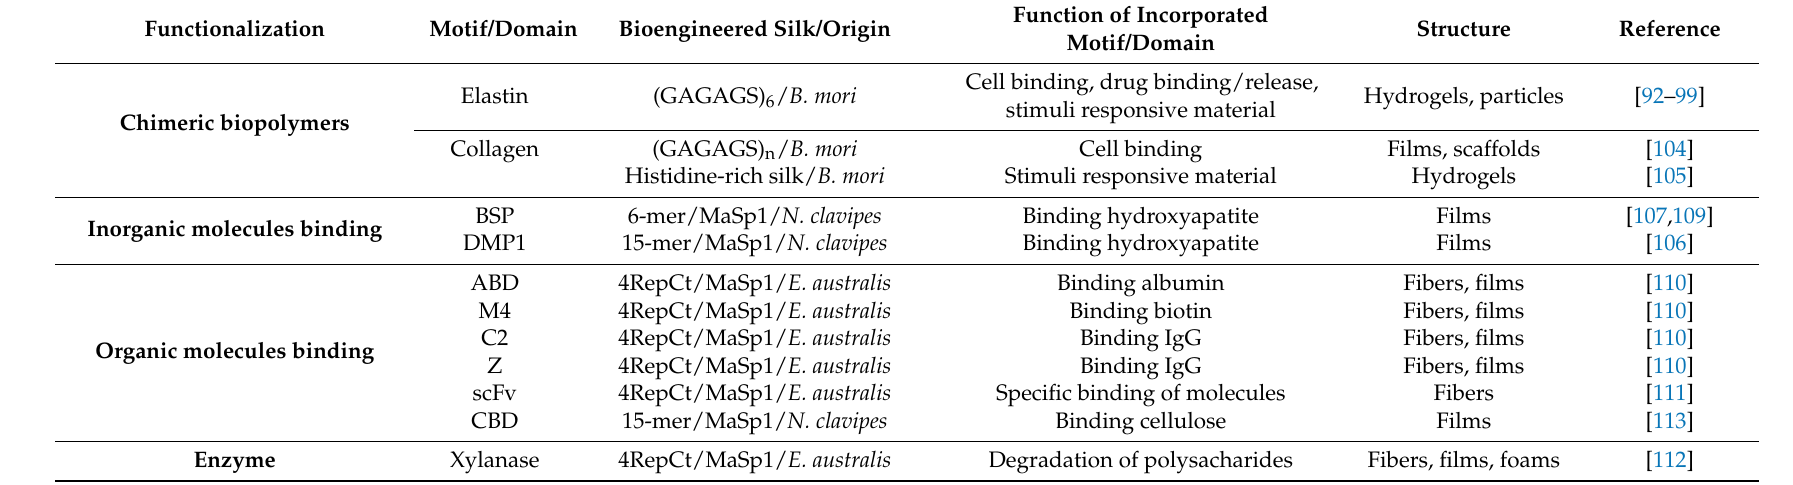
Table 2. Functionalization through incorporation of motifs/domains of proteins of different origin-generation of chimeric